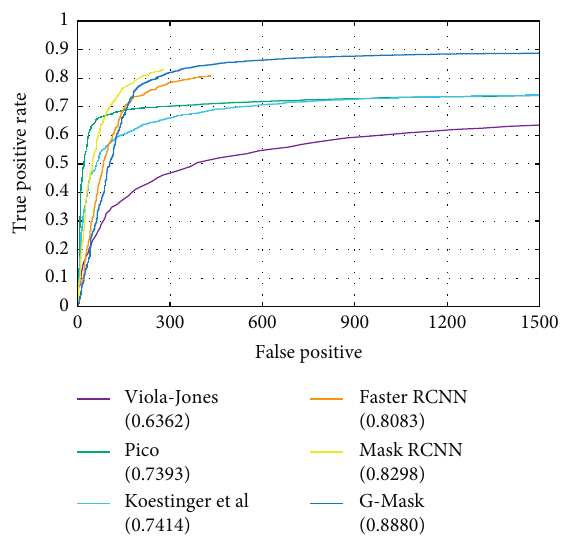
Figure 5: Comparisons of face detection with other methods on FDDB benchmark.